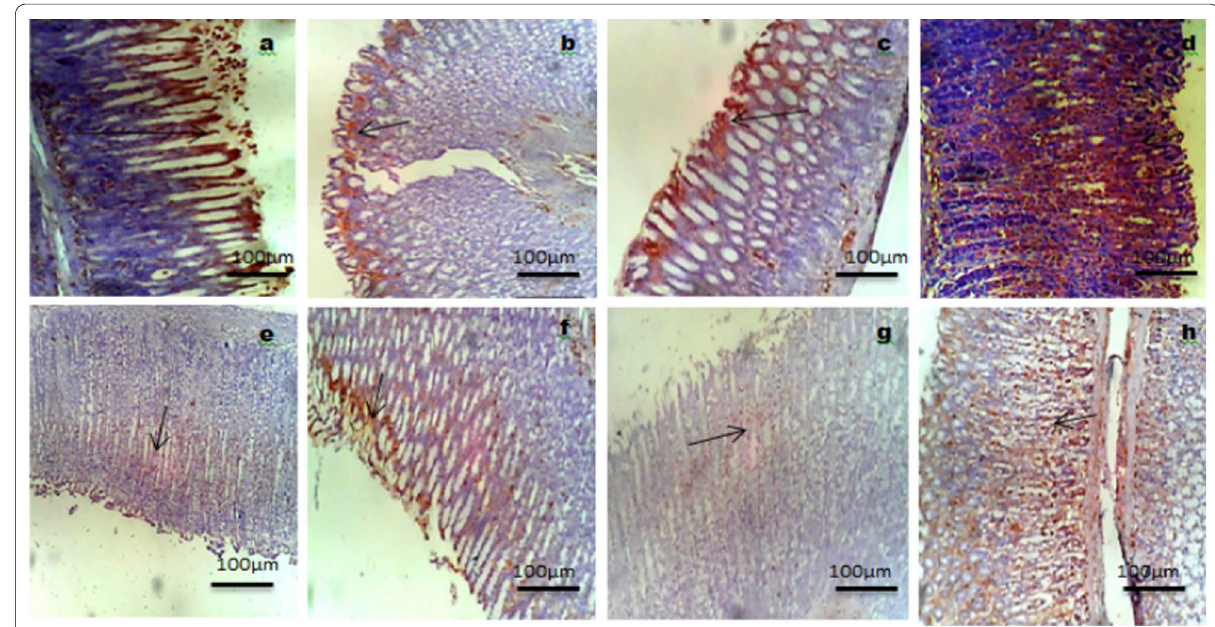
Fig. 13 Representative IHC slides for evaluation of Ki-67 positive immunoreactive cells during healing of acetic acid stomach ulcer pretreated with folic acid and omeprazole. (H&E, X100). a Acetic acid stomach ulcer untreated (Day 5). b Acetic acid stomach ulcer treated with 2 mg/kg Folic acid (Day 5). c Acetic acid stomach ulcer treated with 3 mg/kg Folic acid (Day 5). d Acetic acid stomach ulcer treated with Omeprazole (Day 5). e Acetic acid stomach ulcer untreated (Day 10). f Acetic acid stomach ulcer treated with 2 mg/kg Folic acid (Day 10). g Acetic acid stomach ulcer treated with 3 mg/kg Folic acid (Day 10). h Acetic acid stomach ulcer treated with Omeprazole (Day 10). Black arrow: Point of positivity